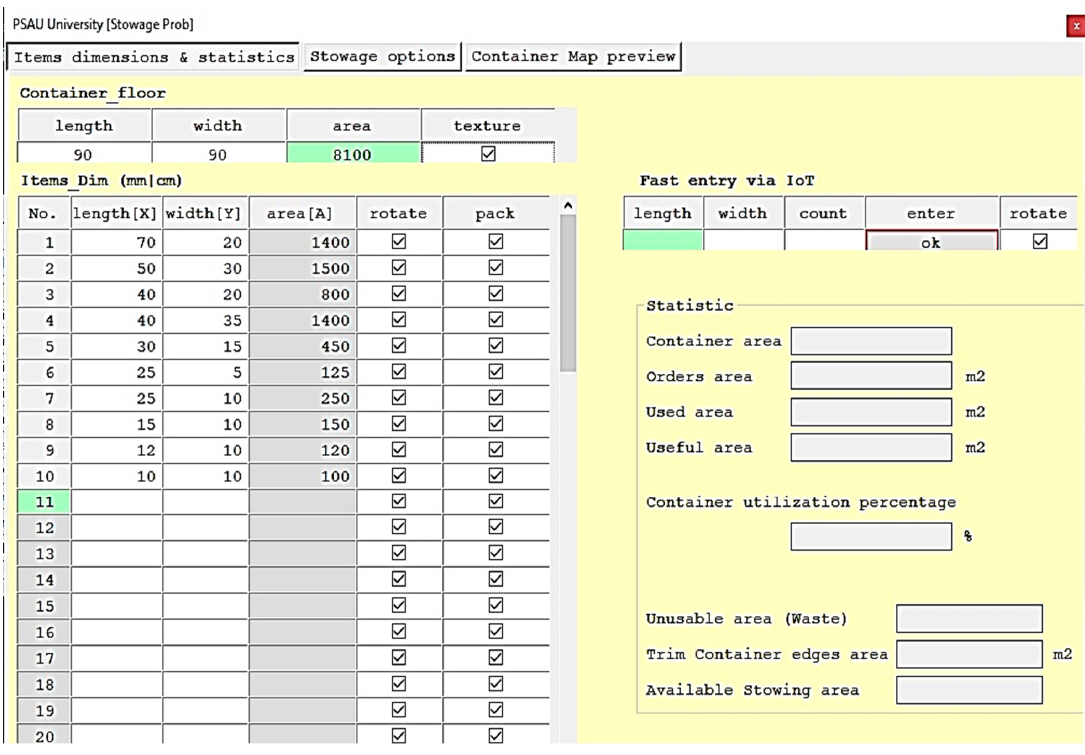
Figure A1. Data of the return products of first station on distribution path aggregated via IoT.